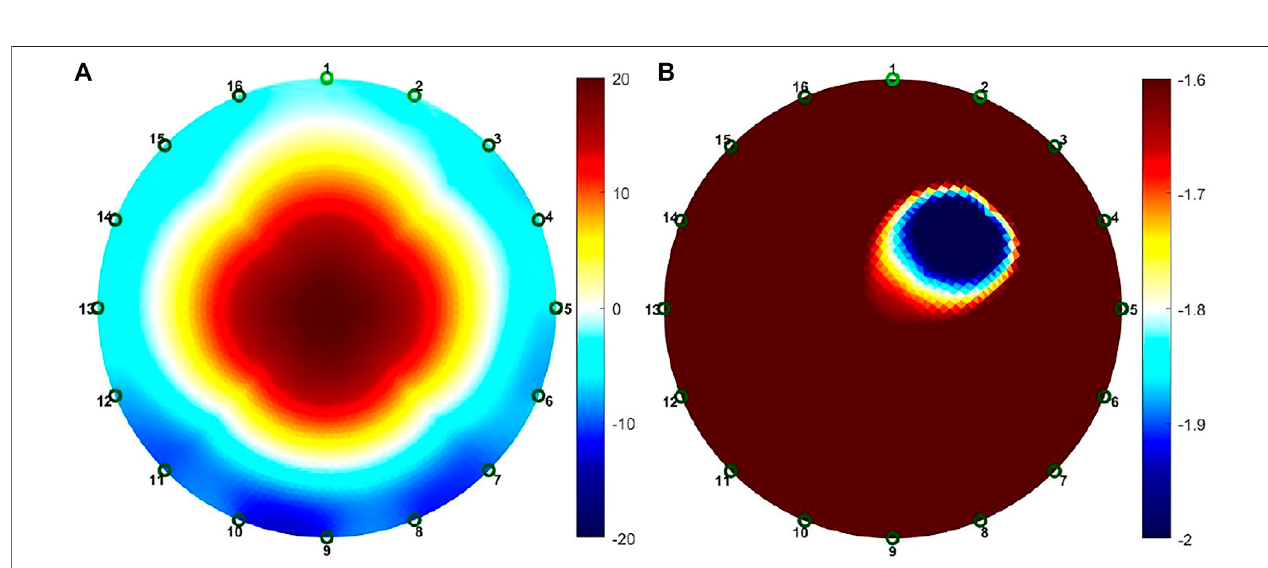
FIGURE 6 | EIT reconstruction performed using data acquired via multiplexers. (A) ZX: saline- fi lled phantom and (B) AX: saline- fi lled phantom containing a low- conductivity cylinder between electrodes 3 & 4, reconstructed using EIDORS. Scales vary for the purpose of generating better image representation.